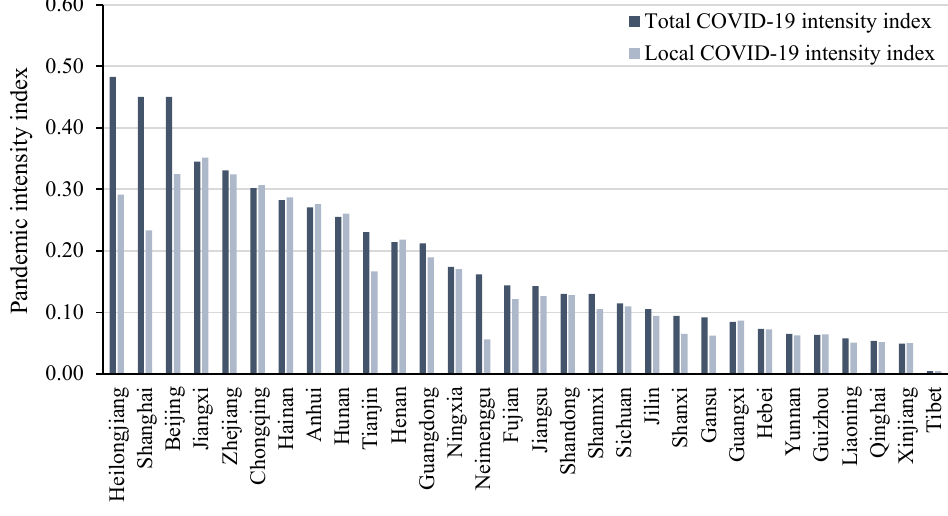
Figure 2. The pandemic intensity index of Chinese provinces.